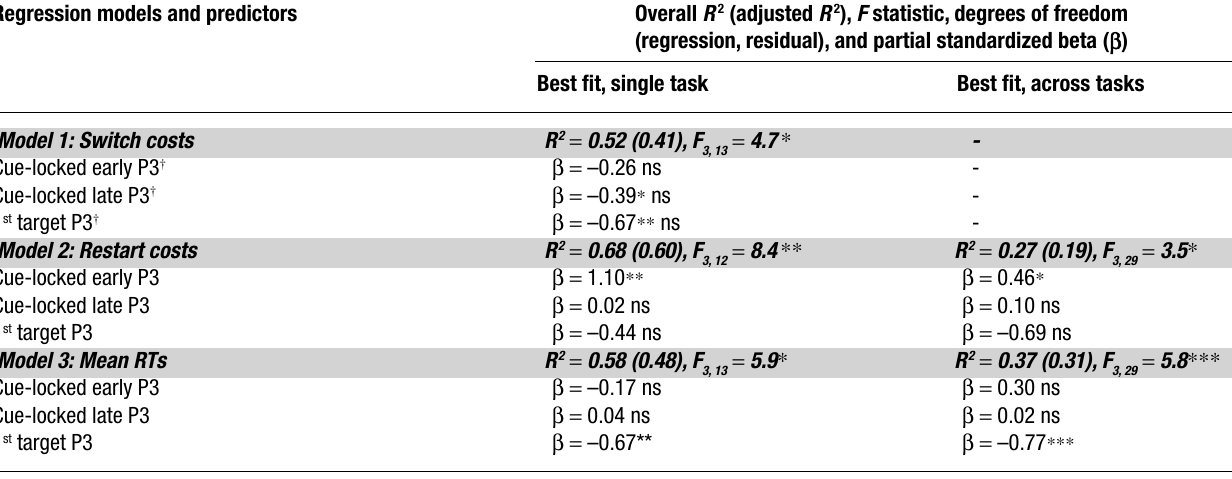
Table 3. Summary of multiple linear regression analyses. The best fi ts were obtained for data from the Switch (models 1 and 2) and Nogo tasks (model 2). None of the 3 models fi tted data from the Oddball